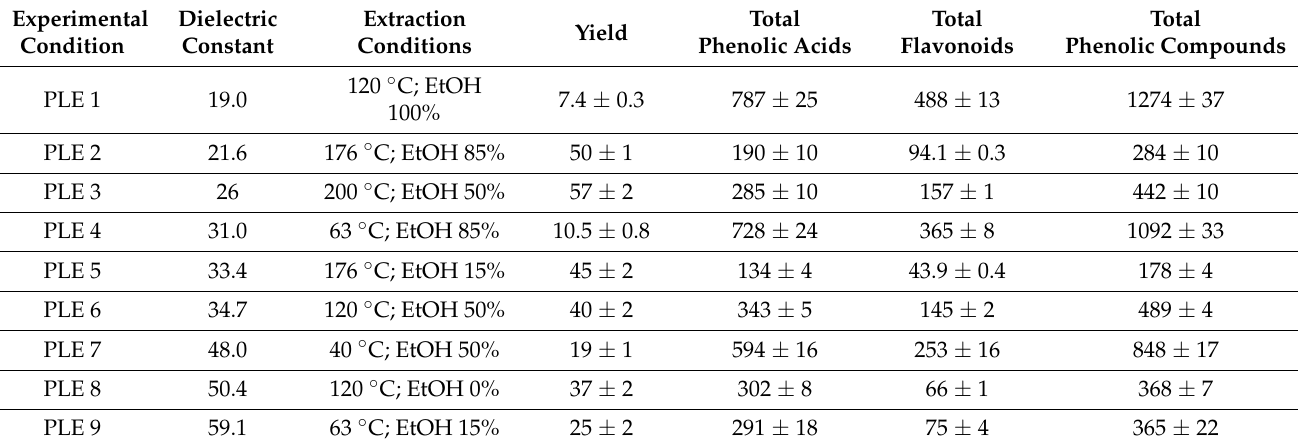
Table 3. Extraction yield and phenolic compounds recovery for C. scolymus L. obtained in each PLE condition. Yield (%), individual phenolic compounds (peak area × E + 4). Value = mean ± standard deviation. Experimental